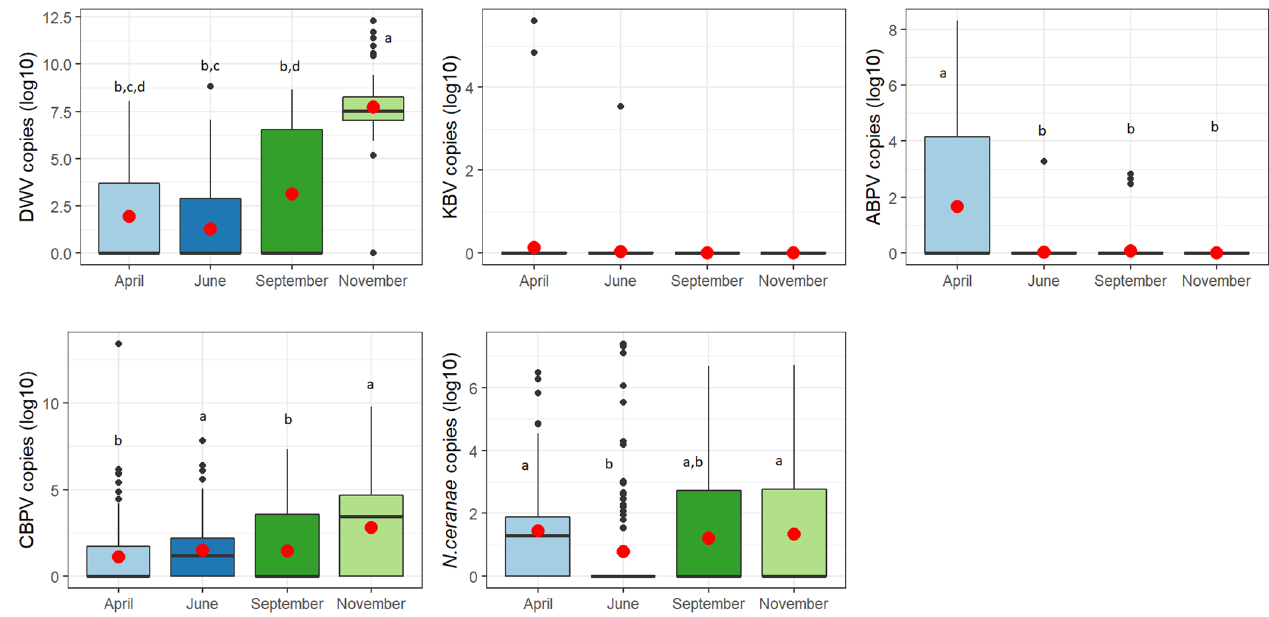
Figure 6. Abundance of each considered pathogen over the year. For a better visualization, data are shown as decimal logarithms. Means are indicated by red dots. Different letters denote significant differences between months.